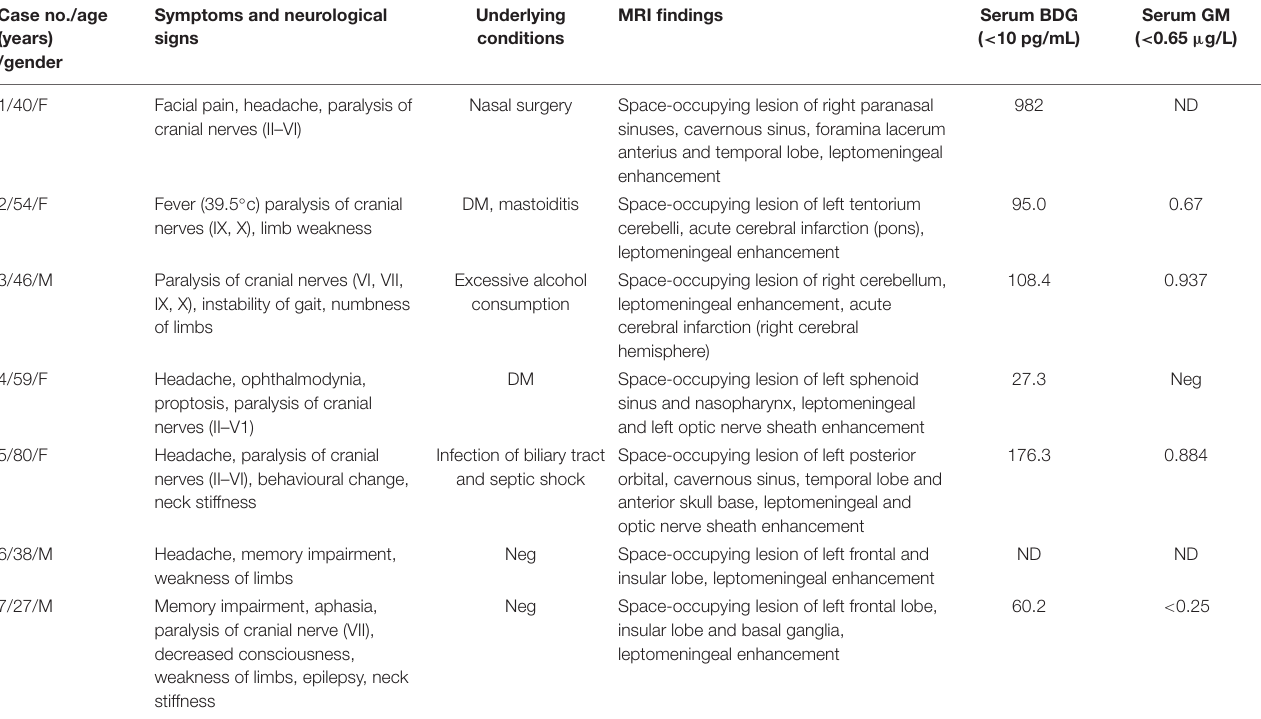
TABLE 1 | Clinical features of seven patients with cerebral